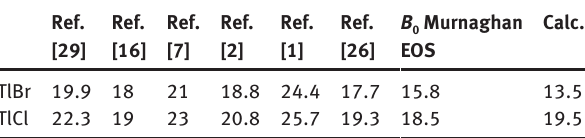
Table 3: Bulk Modulus B(GPa) at T = 0 K.